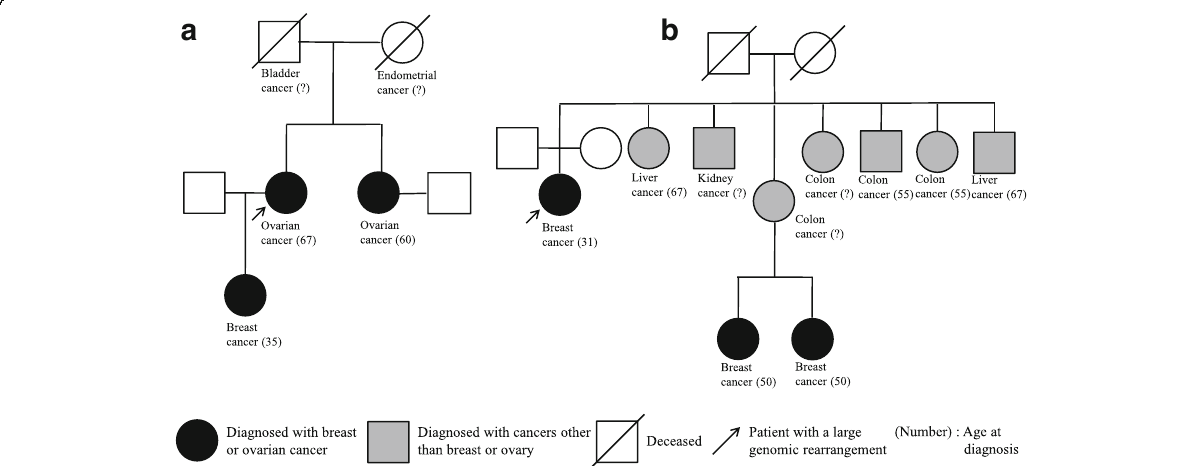
Fig. 3 Pedigree of the 2 patients with large genomic rearrangements identified in this study. ( a ) A patient with a duplication of BRCA1 exon 4-6 and ( b ) a patient who carried a deletion of BRCA1 exon 19